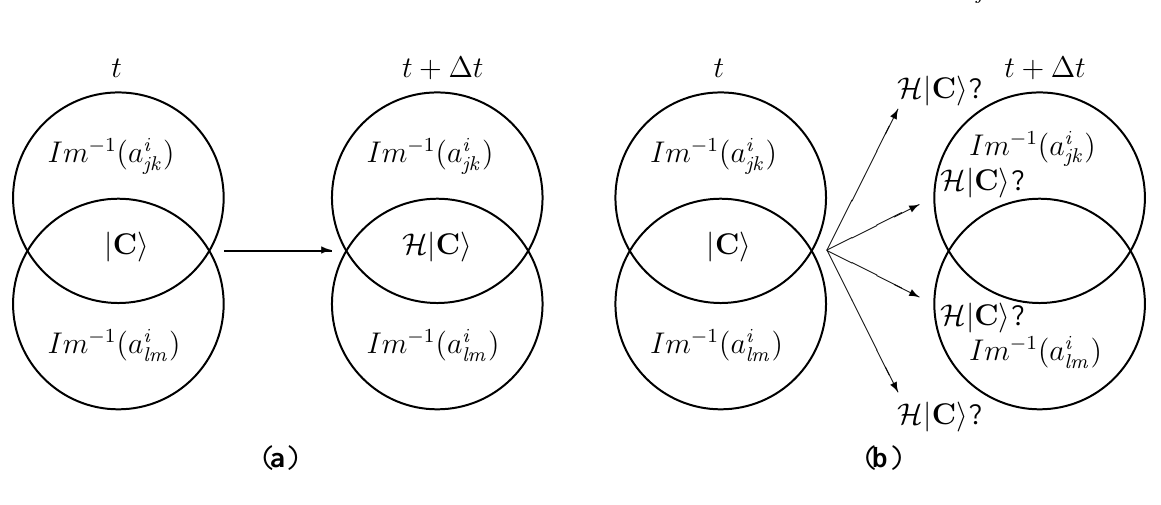
Figure 5. Dynamic evolution of at t . Part ( b ) shows the four possible post-measurement locations of